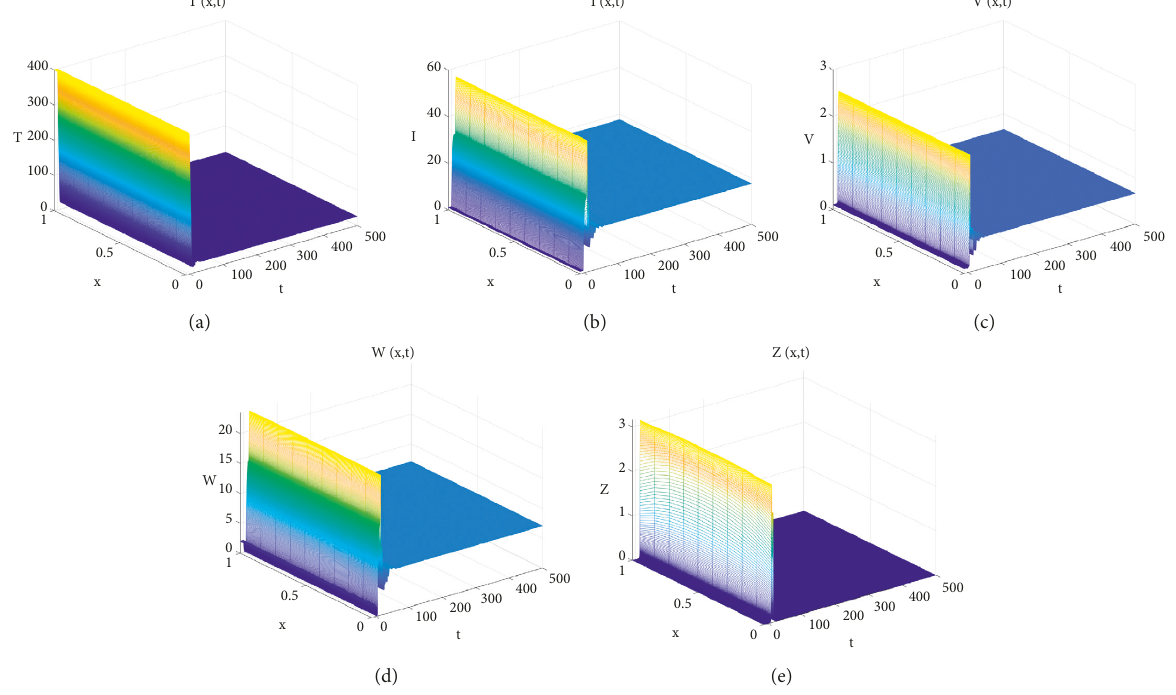
� 0 . 35, and b � 2, we have 3: Taking β 1 R � 98 . 4295 > 1 ,R � 3 . 3053 > 1, and R � 0 . 7818 < 1, E � ( 39 . 9500 , 17 . 3738 , 0 . 6667 , 6 . 9159 , 0 ) is asymptotically 0 1 3 2